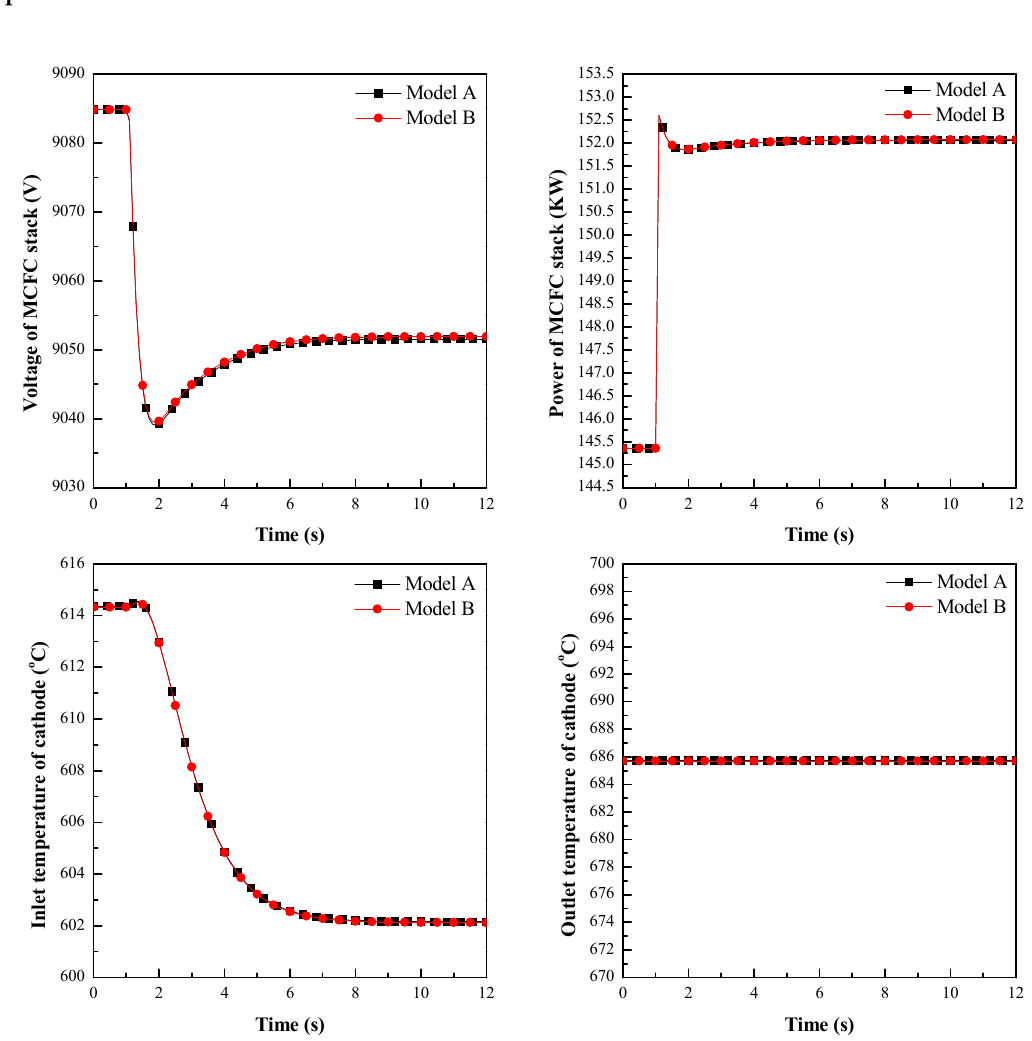
Figure A1. The step-up of MCFC current density—comparison of the fast time scale transient responses of the cell voltage, the fuel cell stack power, the inlet temperature of the cathode, and the outlet temperature of the cathode between the MCFC-MGT model and the MCFC-MGT model based on the Sim–Stim interface model.